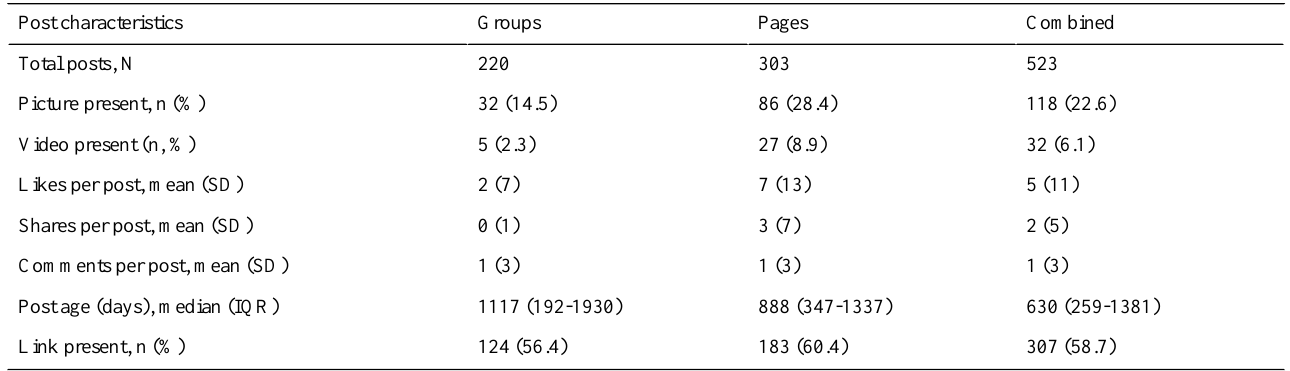
Table 1. Baseline characteristics of posts included in study.